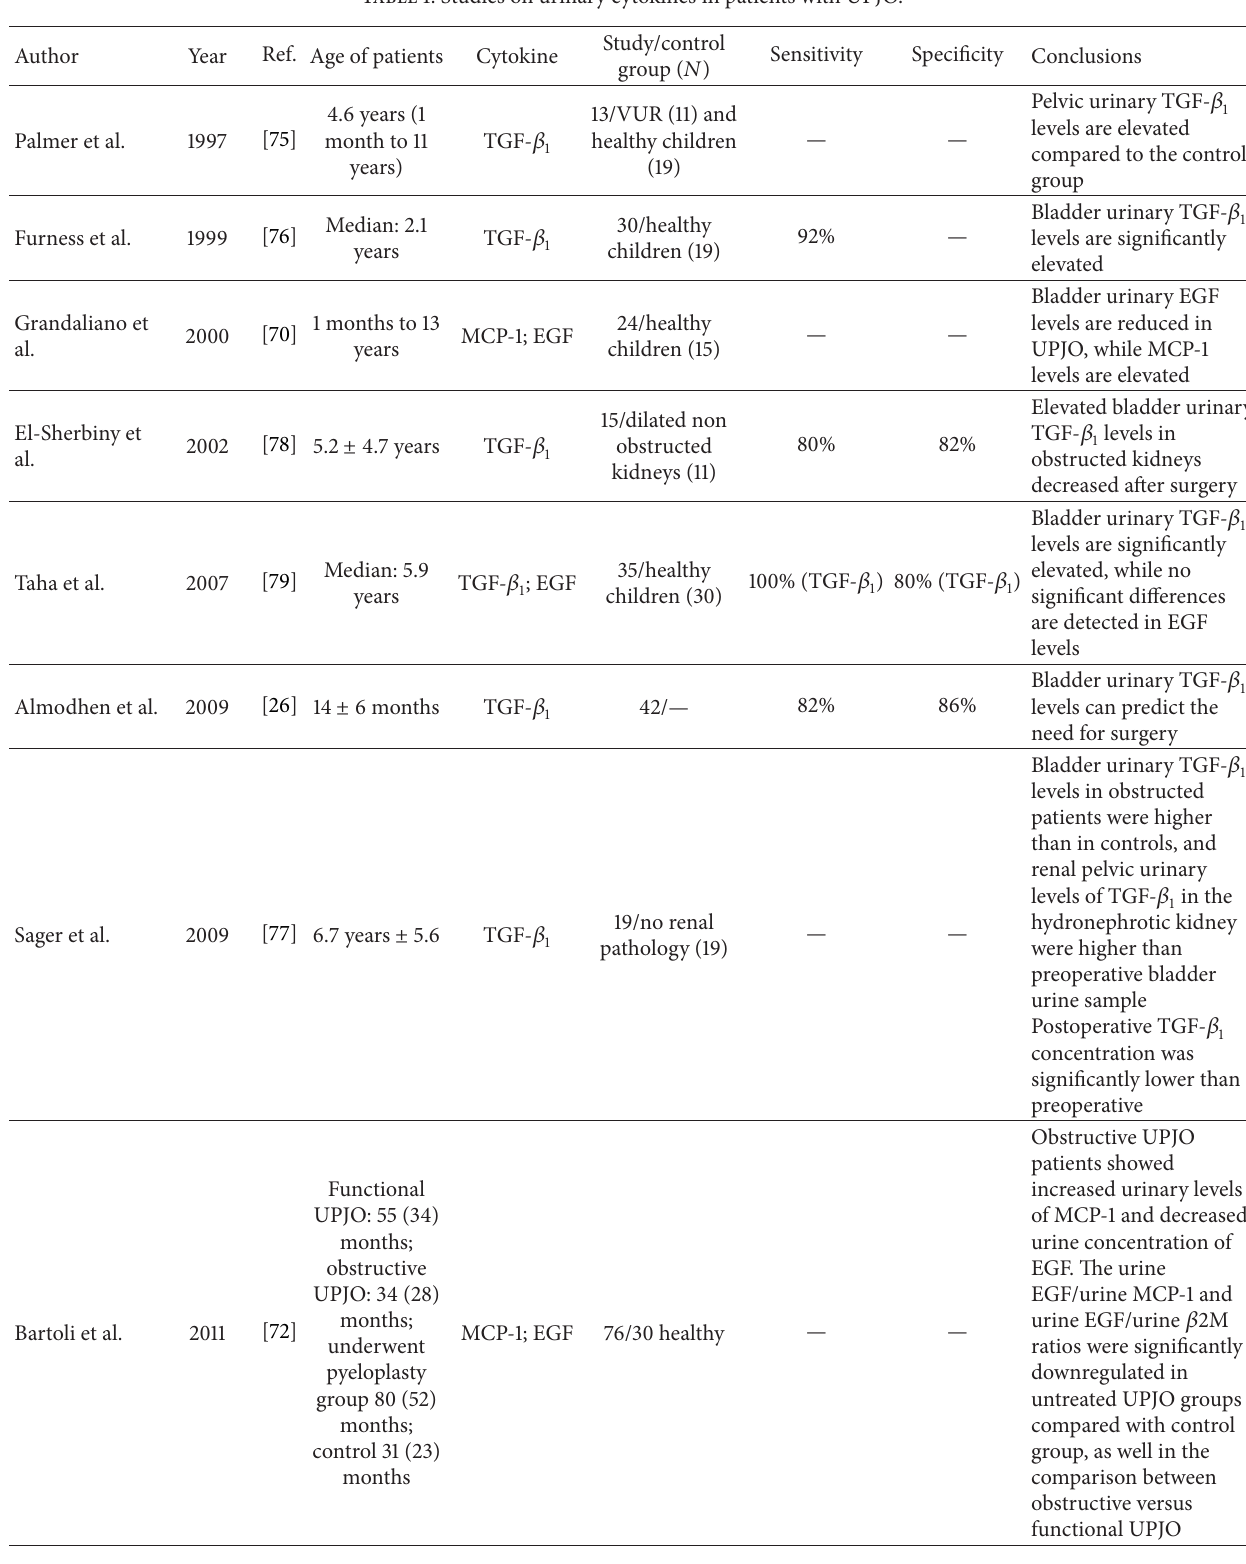
Table 1: Studies on urinary cytokines in patients with